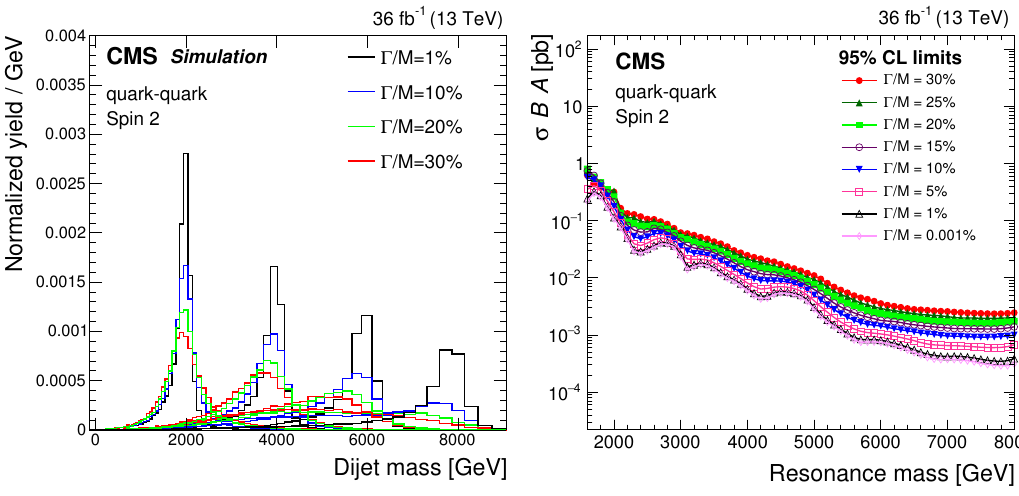
Figure 16 . The resonance signal shapes (left) and observed 95% CL upper limits on the product of the cross section, branching fraction, and acceptance (right) for spin-2 resonances produced and decaying in the quark-quark channel are shown for various values of intrinsic width and resonance mass. The reconstructed dijet mass spectrum for these resonances is estimated from the pythia 8 MC event generator, followed by the simulation of the CMS detector